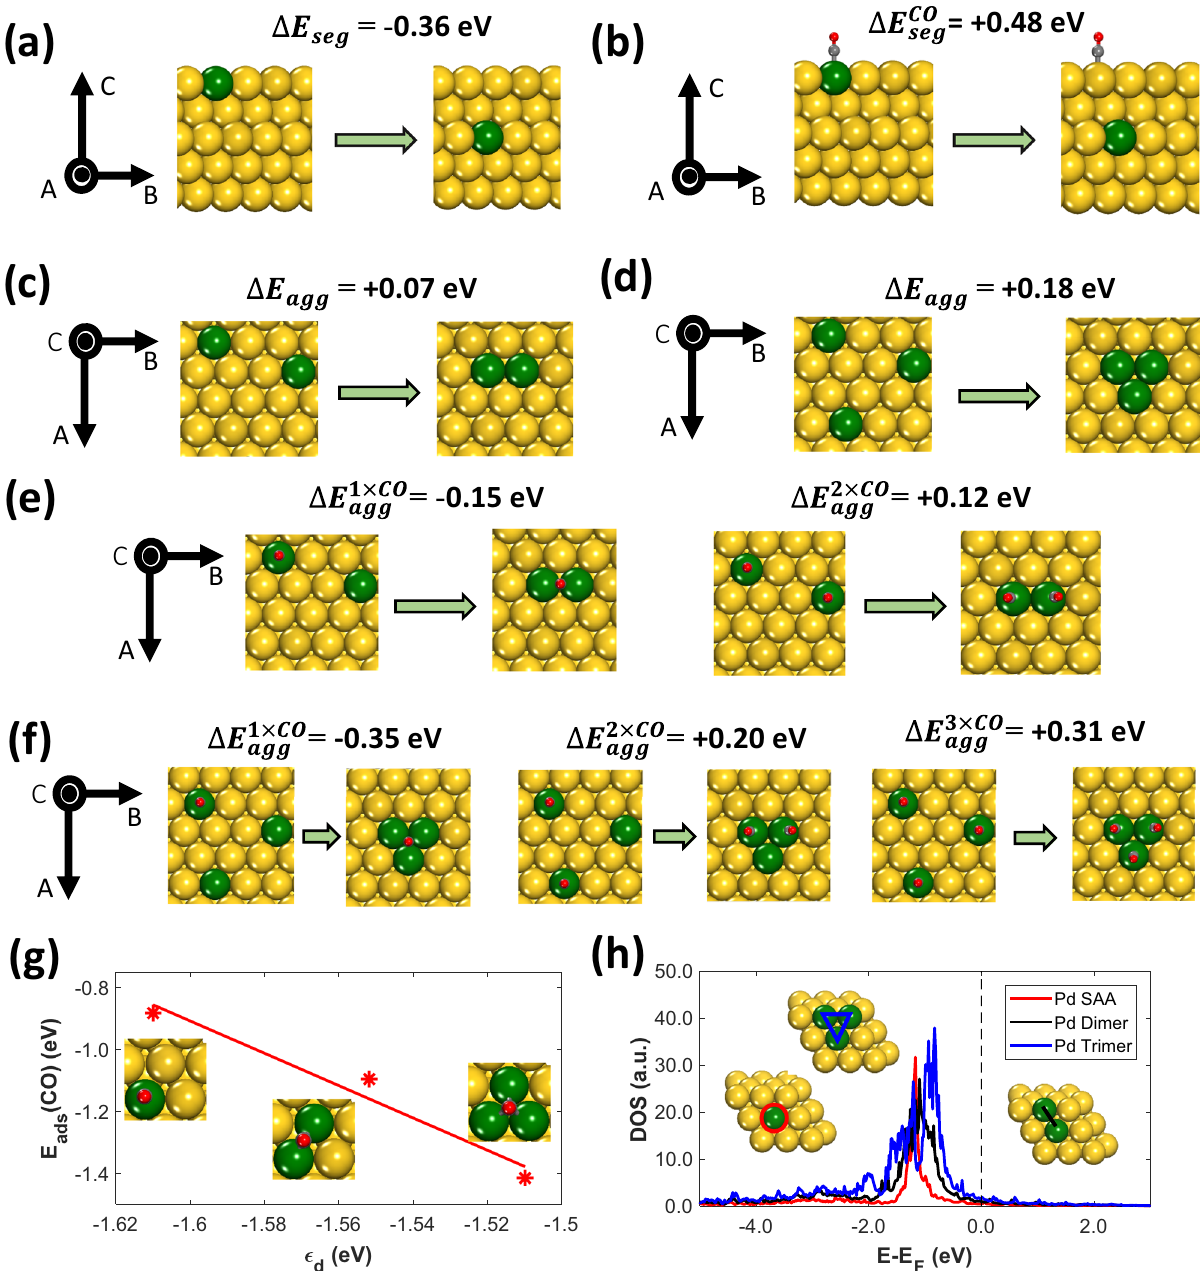
Fig. 1 Predicted effect of CO on Pd segregation and aggregation. Initial and fi nal states for ( a ) Pd segregation; b CO-induced Pd segregation; c Pd – Pd dimer aggregation; d Pd trimer aggregation; e CO-induced Pd – Pd dimer aggregation at different CO fractional coverages; and f CO-induced Pd trimer aggregation at different CO fractional coverages. Values of segregation or aggregation energies are shown on the top of each panel. The given segregation energies in panels ( a ) and ( b ) are per Pd atom; negative segregation energy ( Δ E seg ) values indicate an enthalpic preference for Pd to segregate into the bulk, while positive values indicate a preference for Pd segregation to the surface layer. The reported aggregation energies are given relative to the energy of a SAA; negative aggregation energy ( Δ E agg ) values imply a preference for Pd atoms to cluster into dimers, whereas when Δ E agg > 0 there is a thermodynamic preference for the SAA phase (i.e., isolated Pd atoms in the Au surface). Panels ( g ) and ( h ) show a linear correlation between the CO adsorption energy ( E ads (CO)) and the d band center of the d states of the Pd atoms that comprise the adsorption site, and d density of states (DOS) plots in which the DOS are projected onto the same atoms, respectively. Au, Pd, C, and O atoms are shown in yellow, green, gray and red, respectively. The Pd atoms onto which the d DOS are projected in panel ( h ) are highlighted in the colors of the corresponding DOS plots. In the schematics of the axes, the symbol ◉ denotes an arrow pointing from the page toward the values as the size of the Pd clusters increase and that ε d scales (Fig. 1h), thereby explaining not only the strong Pd linearly with E ads (CO) (Fig. 1g). This observed shift of ε d is the cluster – adsorbate interactions, but also why the cluster samples result of the d density of states (DOS) for dimers and trimers have higher reactivity than the SAA, albeit at the cost of being closer to the Fermi level compared to Pd single atoms selectivity 17,50,51 .